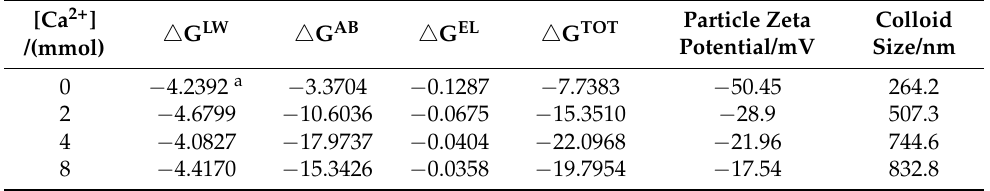
Table 1. Interaction energy, particle zeta potential, and colloid size in different AEM–SA–Ca 2+